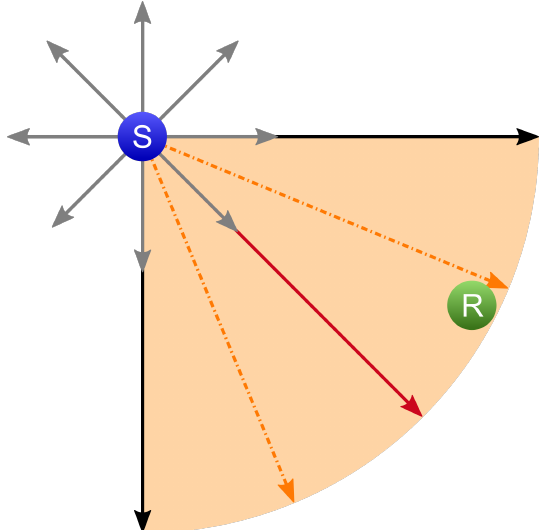
Figure 1. 2D example of the adaptive ray zooming approach. Initial rays are indicated in gray. The ray closest to the receiver is marked in red. Its neighbors, which determine the limits for the next ray zooming iteration, are highlighted in black. Additional rays are launched in between (orange) to double the resolution in a particular direction.